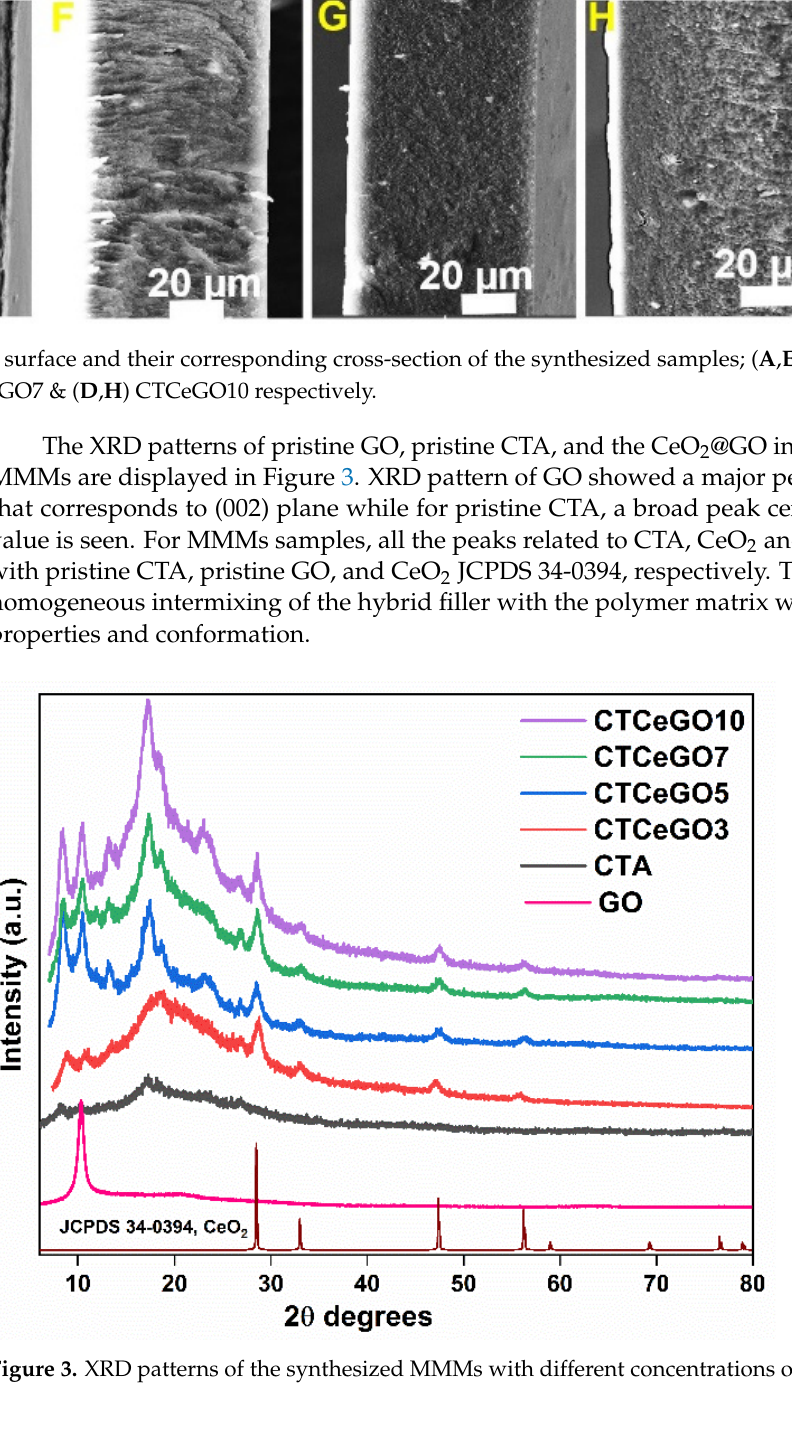
Figure 3. XRD patterns of the synthesized MMMs with different concentrations of GO.